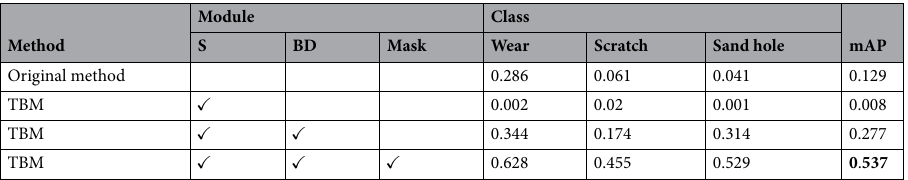
Table 4. Ablation study of the TBM, where S means that we use the local defect dataset to train the network, BD represents the block division method, and the best result is in bold.